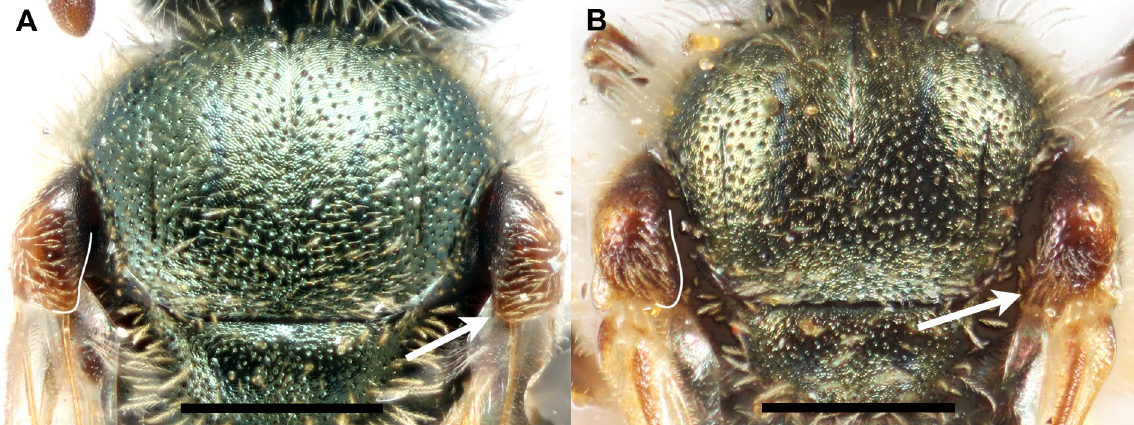
Fig. 100. Tegulae. A . Lasioglossum diabolicum sp. nov., ♀, with blunt posterior angle (white outline and arrow). B . L. stictaspis (Sandhouse, 1923), ♀, with rounded posterior projection (white outline and arrow). Scale bars = 0.5